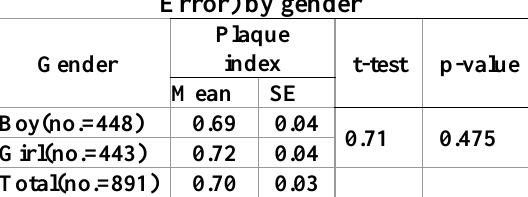
Table 2: Plaque Index (Mean and